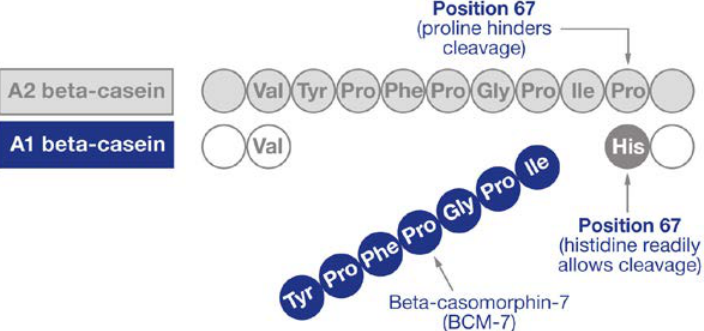
Figure 1. Release of beta-casomorphin-7. Adapted from Woodford [12] (reproduced with permission of the publisher).